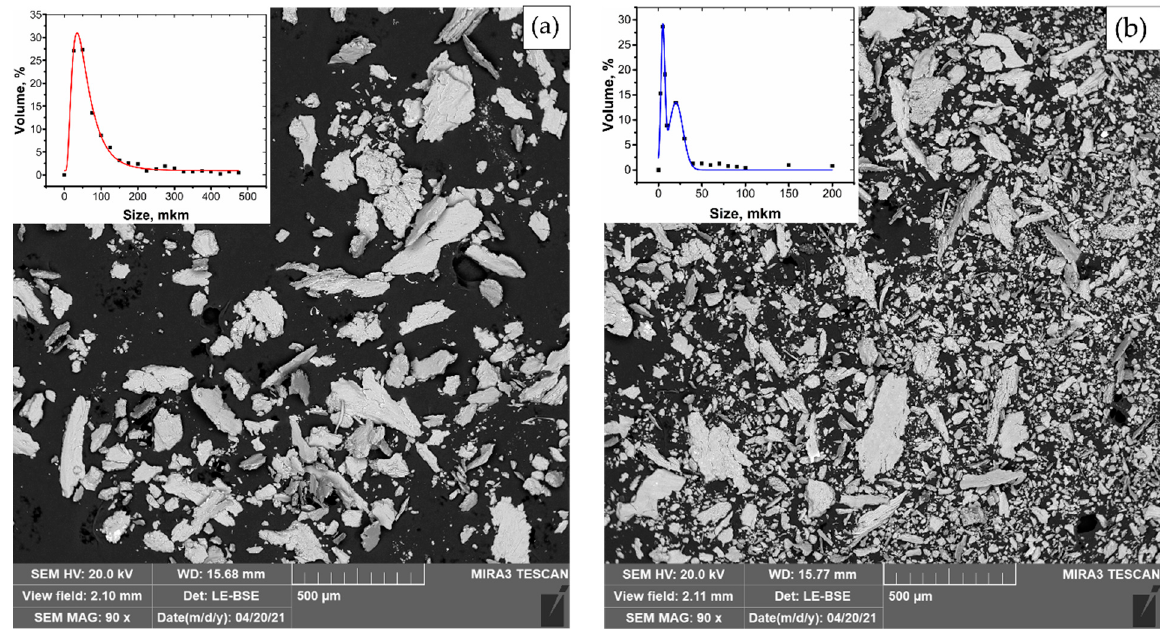
Figure 11. SEM analysis of debris of Al-2%f.s composites ( a ) and Al-2%f.s-2%Cu ( b ). The debris of Al-2%f.s composite consists mainly of large detached flakes with an average size of about 60 microns; the fine fraction is practically absent. For the Al-2%f.s- 2%Cu composite, fine flakes with an average size of 5 μ m are predominant. This explains the lower wear rate of this material. In [27], it is noted that debris of a size less than 5 microns indicates low friction and wear.